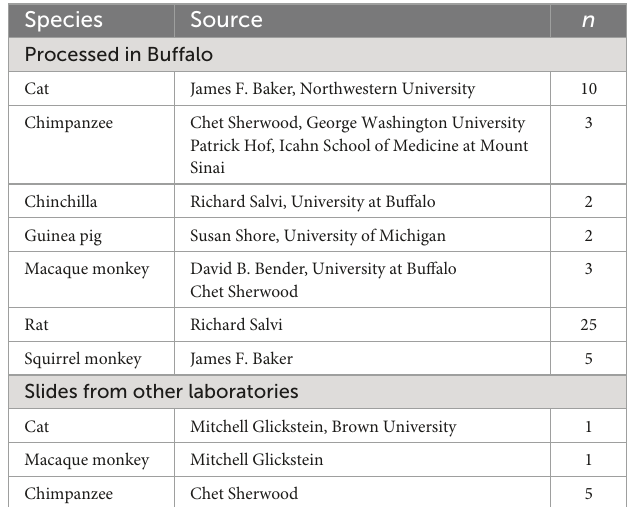
TABLE 2 Animal cases.